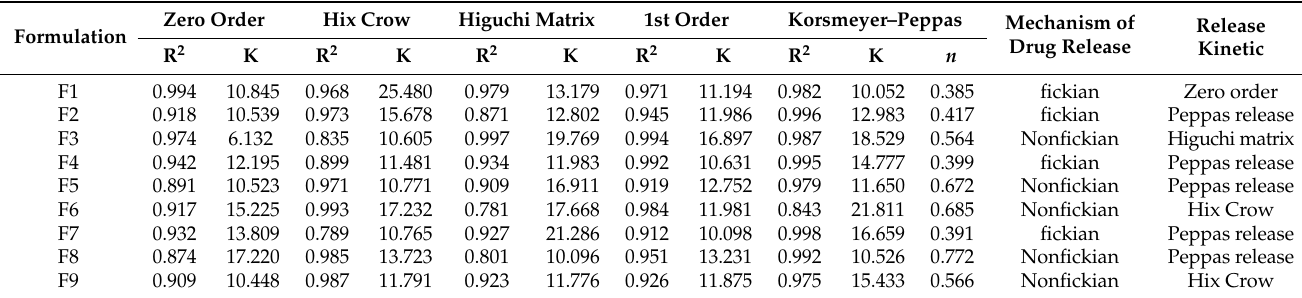
Table 5. Kinetic studies of the dissolution profile of NTB matrix tablets (values of R 2 , k, and n ) and mechanism of drug